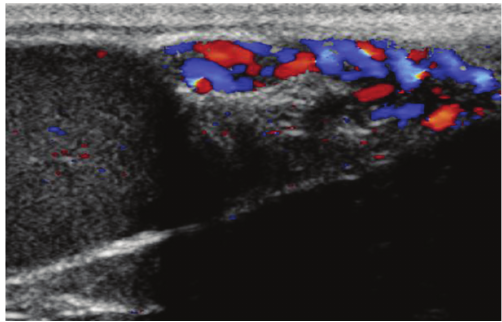
Figure 5: Ultrasonogram of a testis using color pulsed-wave Dop- pler ultrasonography showing blood flow within the supratesticular artery.